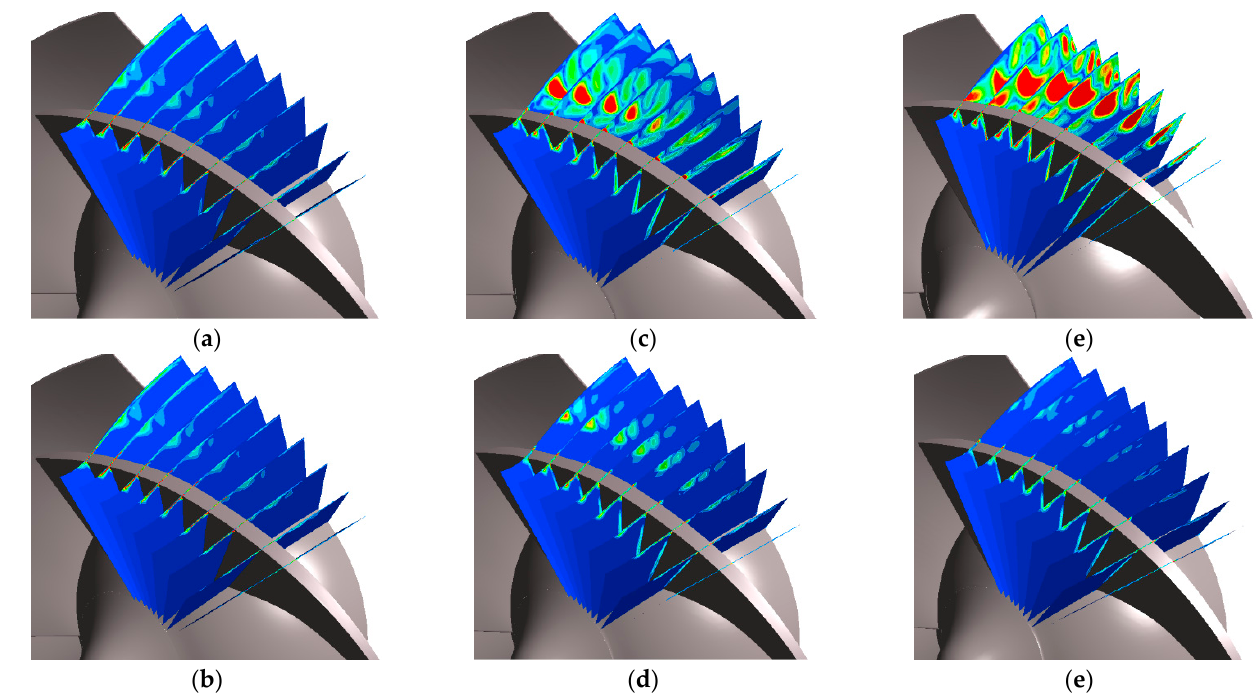
Figure 17. Distribution of gap L 2 . ( a ) e = 0 mm, ( b ) e = 0 mm, ( c ) e = 3 × 10 − 1 mm (small gap), ( d ) e = 3 × 10 − 1 mm (large gap), ( e ) e = 5 × 10 − 1 mm (small gap), ( f ) e = 5 × 10 − 1 mm (large gap).